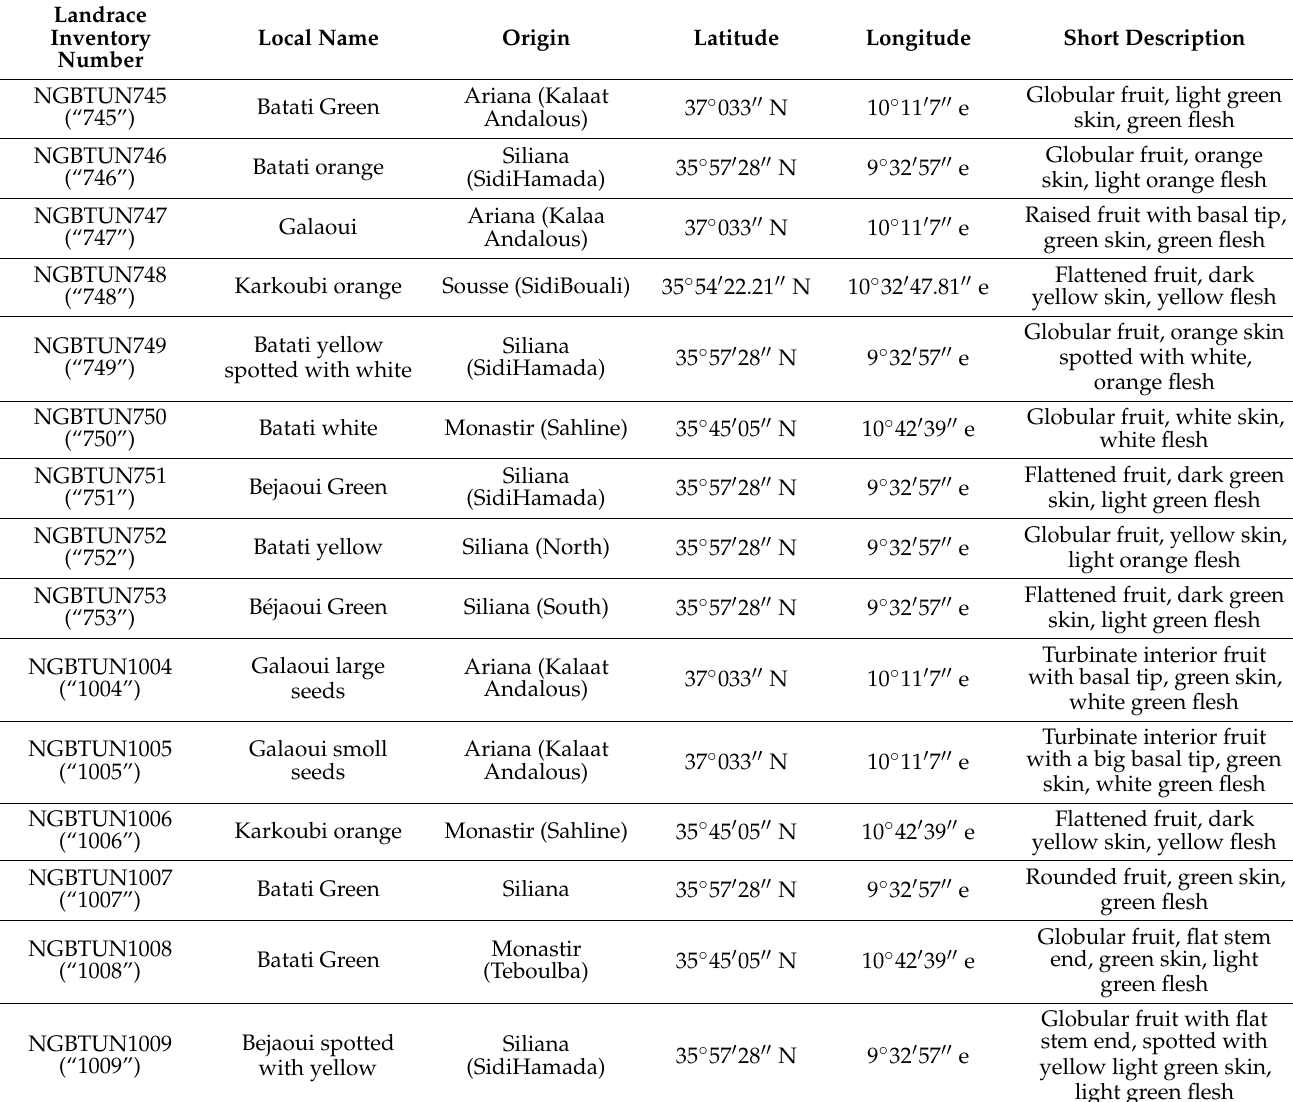
Table 8. Description of the Tunisian squash landraces employed in this